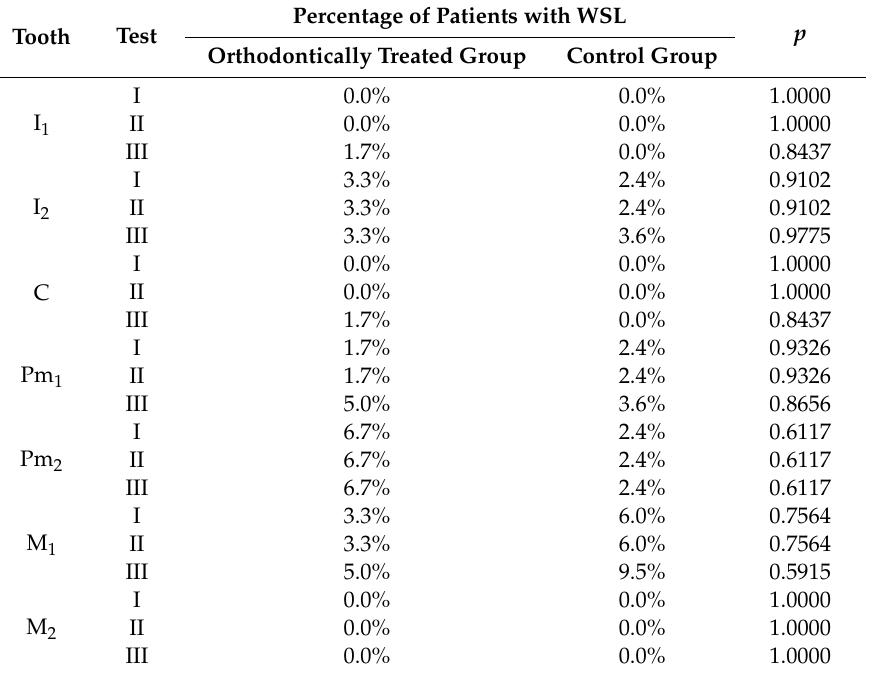
Table 1. Patients with white spot lesions (WSL) in orthodontically treated and control groups. Tooth